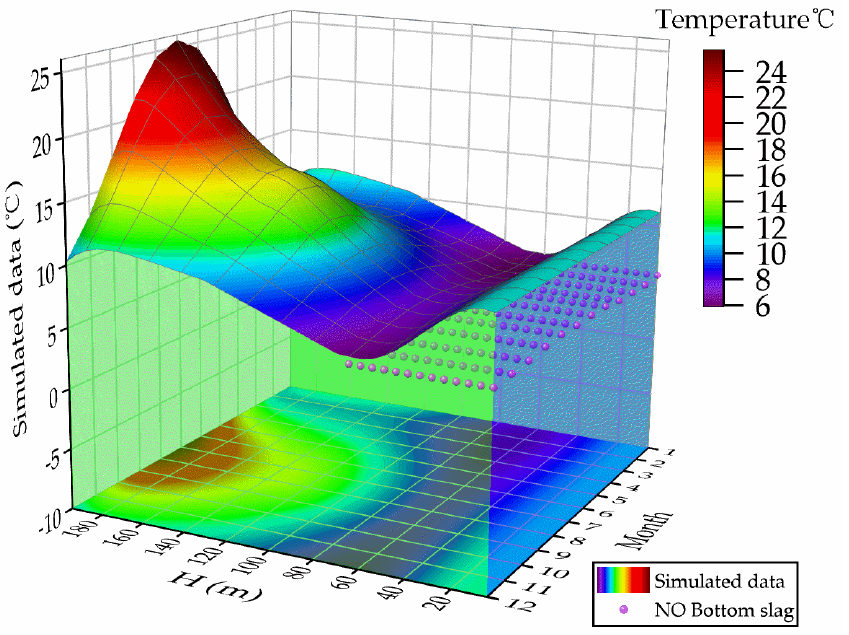
Figure 6. Water temperature of Xulong Reservoir (bottom slag 40 m).